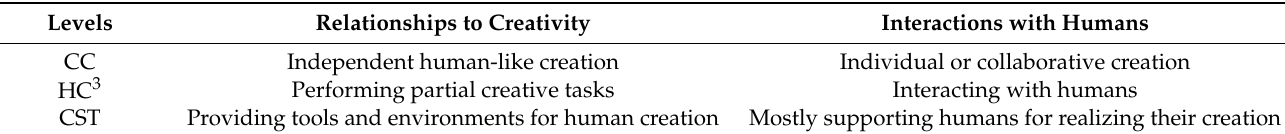
Table 2. The three levels of computational creativity: computational creativity (CC), human–computer (co-)creativity (HC 3 ) and creative support tool (CST).